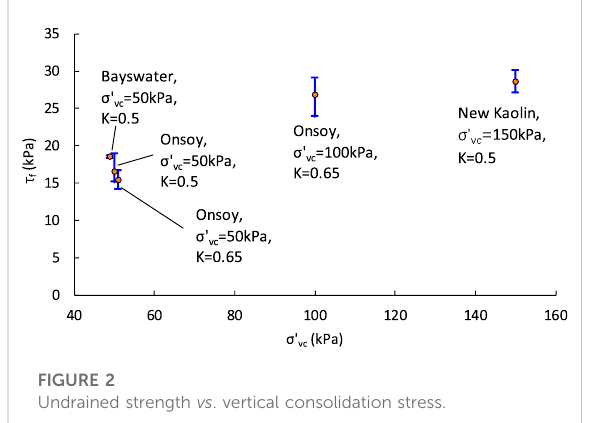
FIGURE 5 Variation in undrained strength ratio with lateral stress ratio.